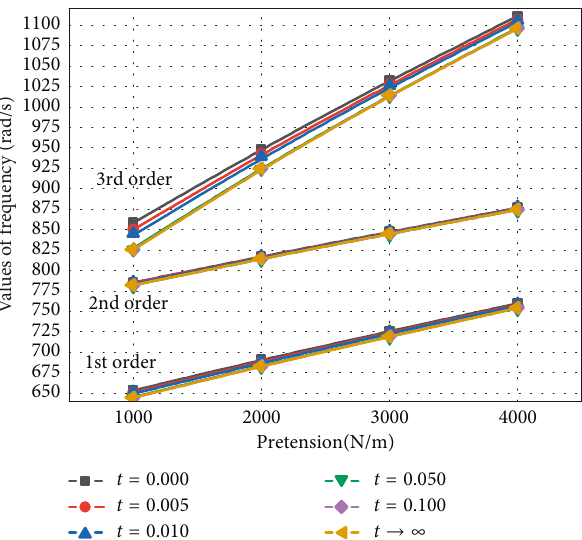
Figure 13: Frequencies (rad/s) under different pretension levels and time instants. Table 6: Frequencies (rad/s) under different arch-to-span ratios and time